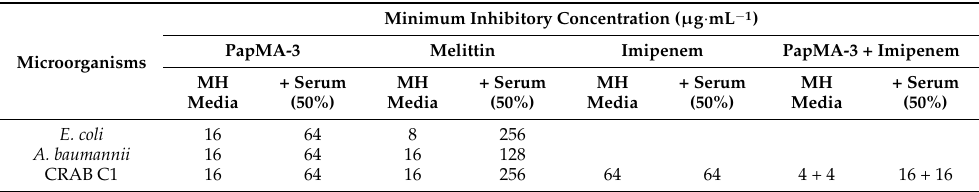
Table 4. Measurement of serum stability of PapMA-3 and melittin against E.coli , A.baumannii , and CRAB C1.